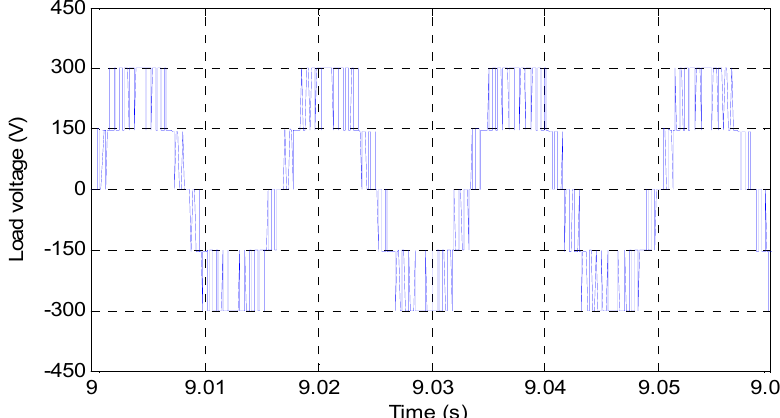
Figure 6. Load voltage waveform.